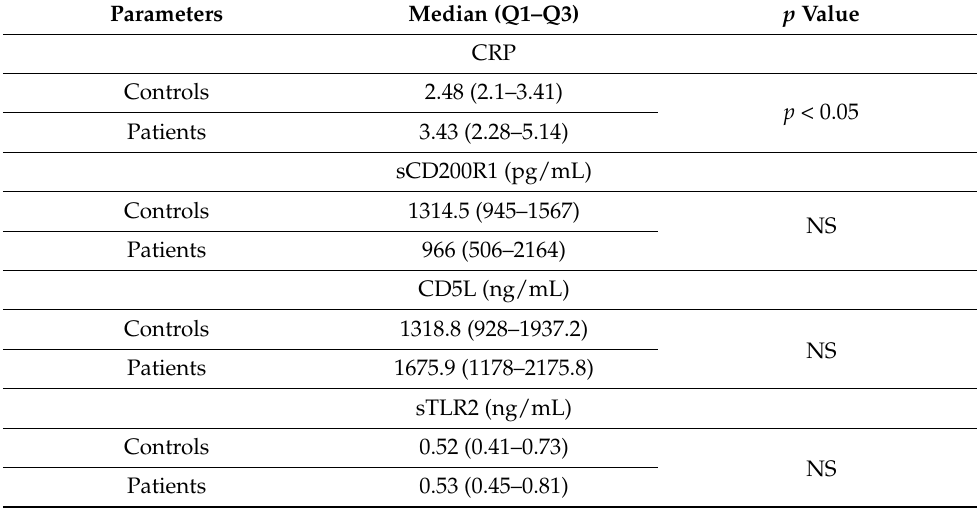
Table 4. The levels of selected markers in controls and